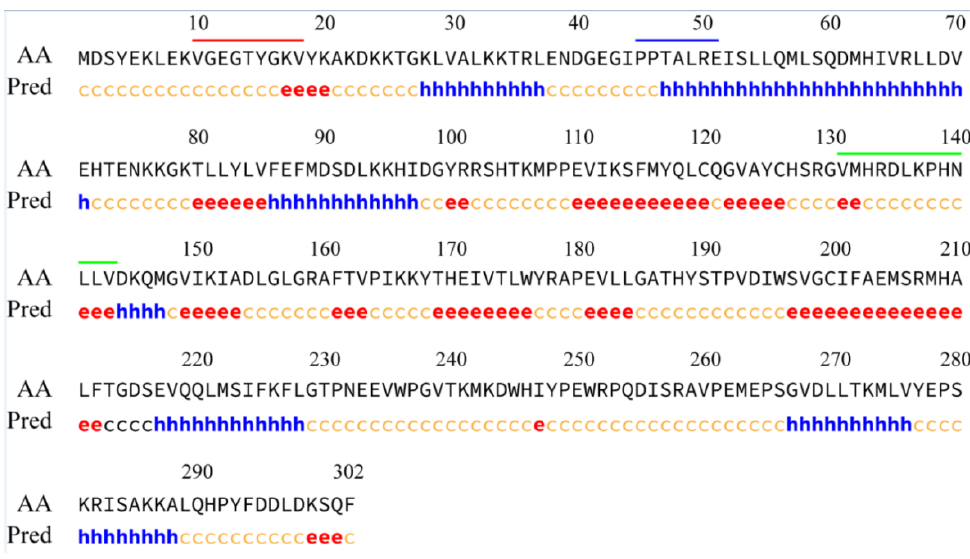
Figure 1. Structures and conserved domains of the LaCDKB1;2 protein. e: α-helixes; h: β-strands (extended strands); c: random coils. Red line: ATP-binding region signature [V(10)GEGTYGKV(18)]; blue line: PPTALRE motif; green line: serine/threonine protein kinase acting-site signature [V(131)MHRDLKPHNLLV(143)]. AA: amino-acid sequence; Pred: prediction of secondary struc- tures.